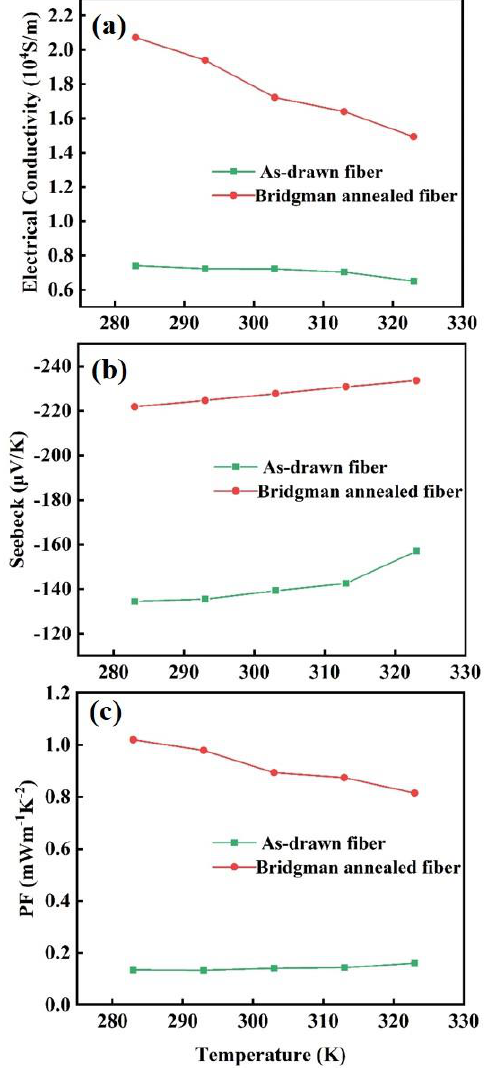
Figure 4. ( a ) Electrical conductivities, ( b ) Seebeck coefficients, and ( c ) power factors of the as-drawn fibers and the Bridgman-annealed fibers at 283 – 323 K. fibers and the Bridgman-annealed fibers at 283–323